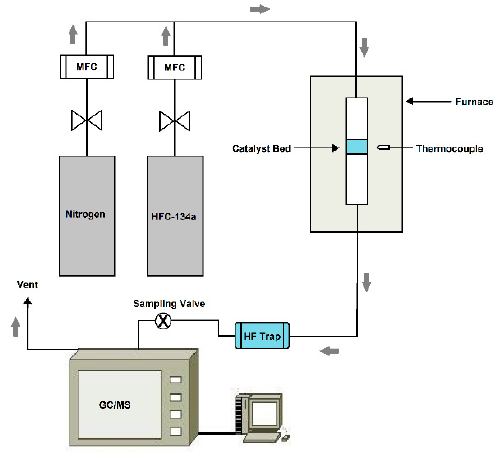
Figure 8. Schematic diagram of experimental setup for the catalytic decomposition of HFC-134a.